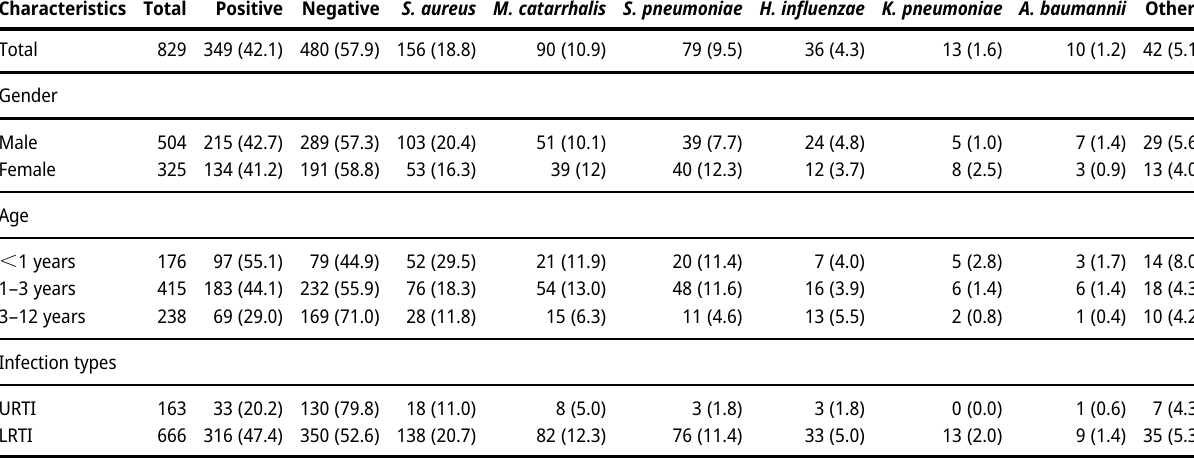
Table  : The distribution of common respiratory bacteria in  children with RTIs. Characteristics Total